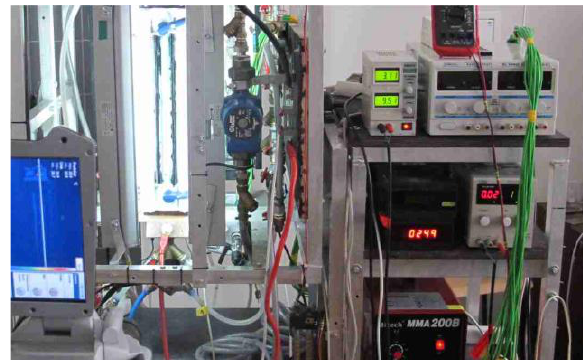
Fig. 1. A view of the experimental stand with a test section with rectangular minichannels or an annular minigap.